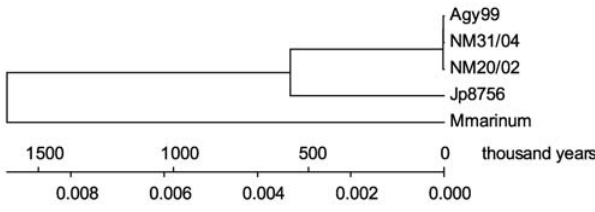
Figure 6. Minimum evolution tree based on 1,032,790 allelic codons of the M.ulcerans and M.marinum strains. The scale shows the divergence time frame and the number of synonymous substitu- tions per nucleotide site. The rate of synonymous substitution used for time calibration was 5.8 6 10 2 9 substitution per site per year.